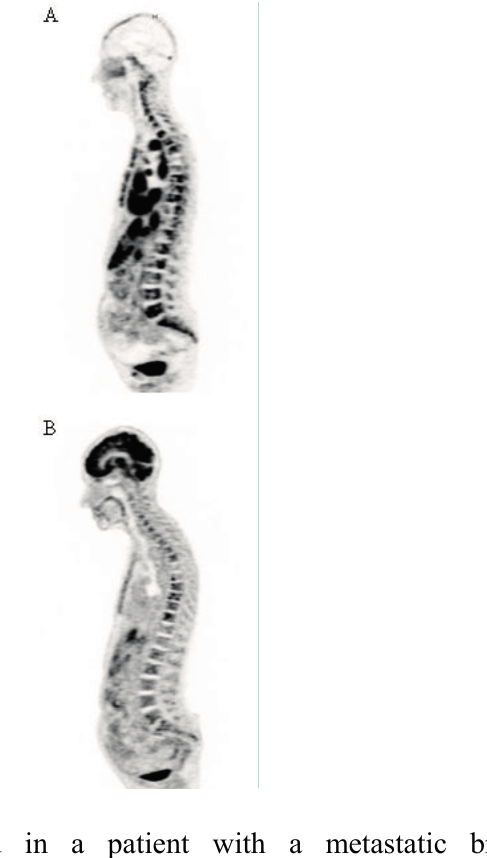
Figure 4. Imaging performed in a patient with a metastatic breast carcinoma. ( A ) Immuno-PET performed using the TF2 anti-CEA bispecific antibody and the 68 Ga-IMP-288 peptide detects a more diffuse bone marrow involvement that FDG-PET ( B